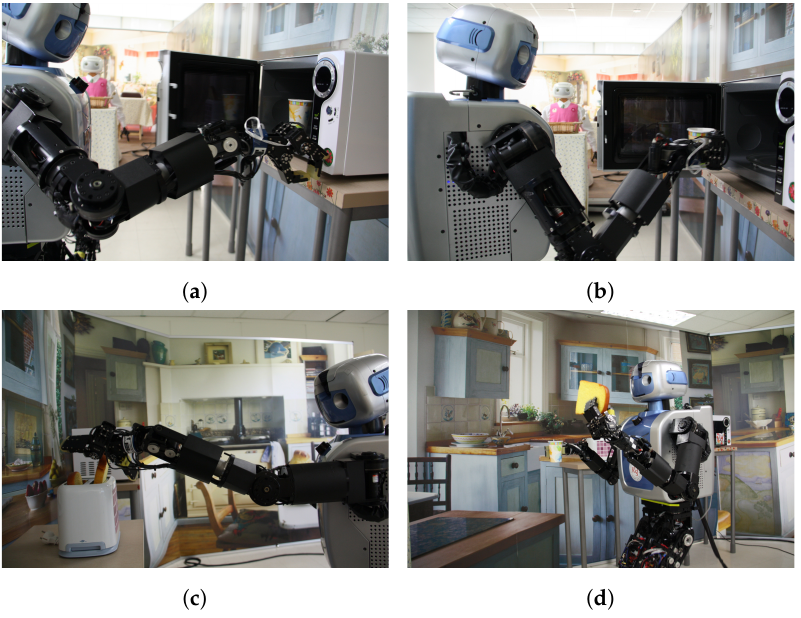
Figure 19. Screenshot of robot tasks in a domestic environment: ( a ) Push a button; ( b ) Grasp a cup; ( c ) Grasp toast; ( d ) Deliver the toast to a